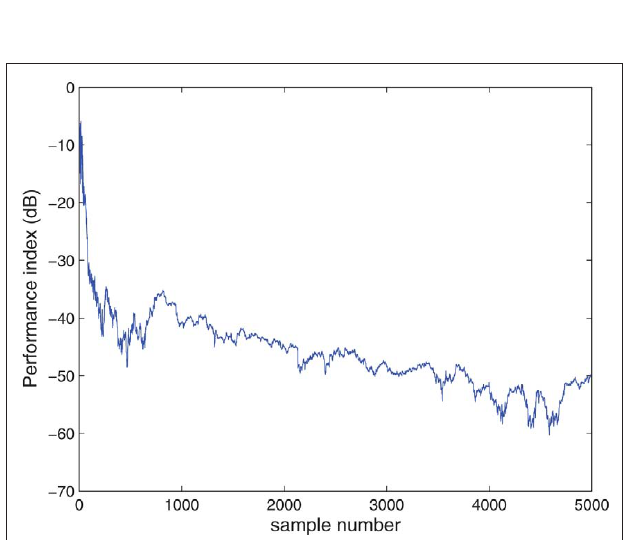
( k ) is shown in the bottom-right plot. 1